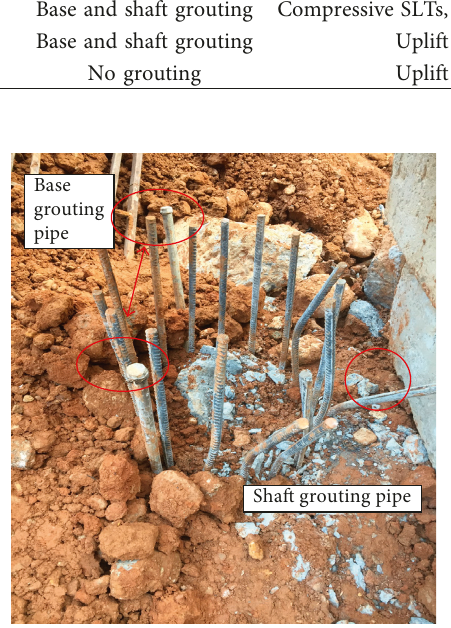
Figure 2: Base and shaft grouting system.